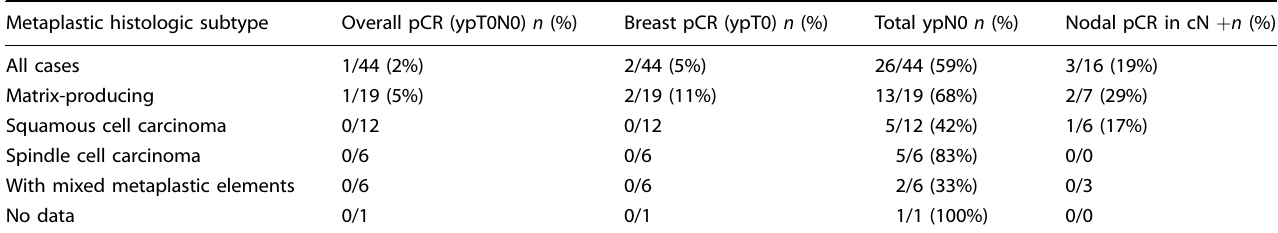
Table 3. Rates of pathologic complete response in breast and lymph node strati fi ed by histologic subtype of metaplastic carcinoma. Metaplastic histologic